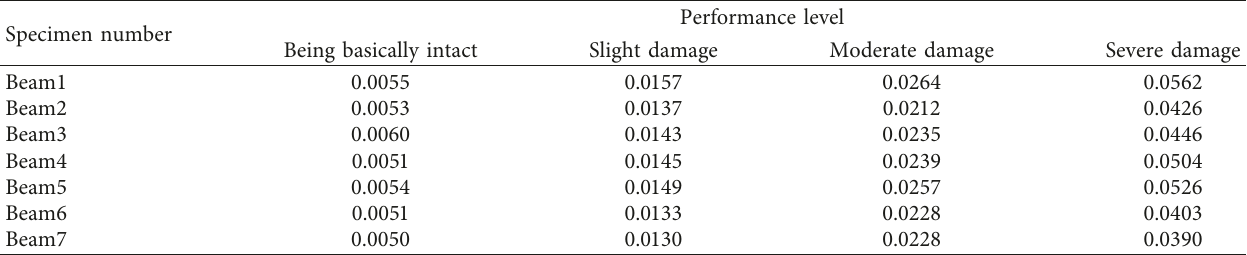
Table 9: Chord rotations of SRC coupling beams at different performance levels